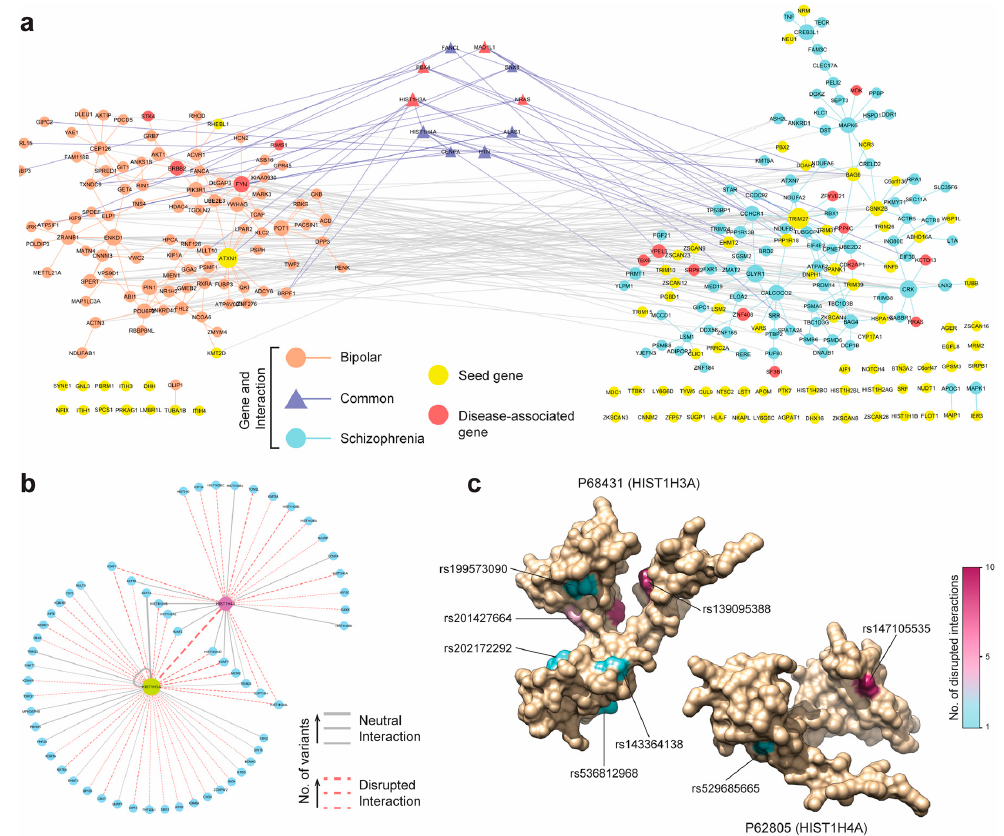
Figure 5. Analysis of Bipolar disorder and Schizophrenia modules discovered by DIMSUM. ( a ) The BPD and SCZ modules are represented by the left and right components respectively, and the genes common to both disorders are in the small central component. DIMSUM discovers a total of nineteen disease- associated genes in both modules. ( b ) The rewiring of the subnetwork centered around the shared histone genes HIST1H3A and HIST1H4A . The dash lines indicate the accumulative damage based on the SNP-IN predictions. ( c ) Protein structures for the histones HIST1H3A and HIST1H4A on the left and right respectively. Disruptive mutations occurring on these two genes are observed in both BPD and SCZ; HIST1H3A carries six disruptive mutations and HIST1H4A carries two. The color of each mutated residue corresponds to the number of interactions it disrupts.